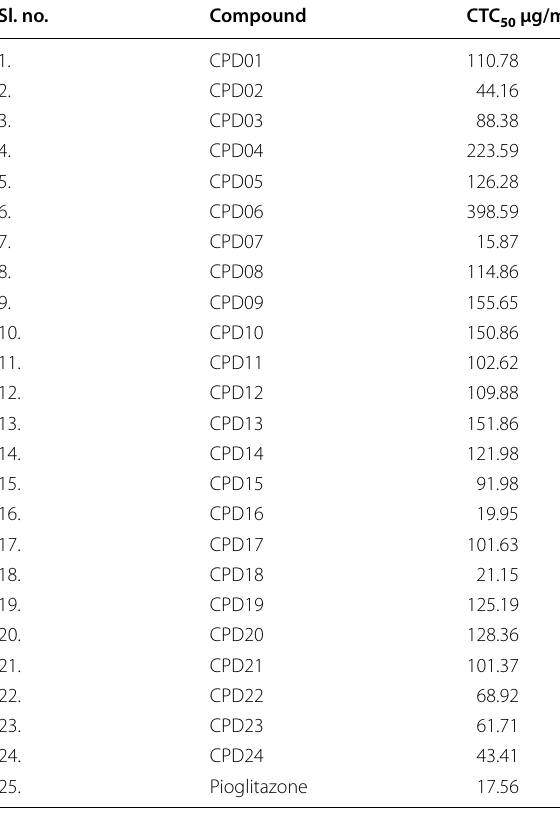
Table 4 Cytotoxicity data for the synthesized compounds against 3T3-L1 cells Sl. no.